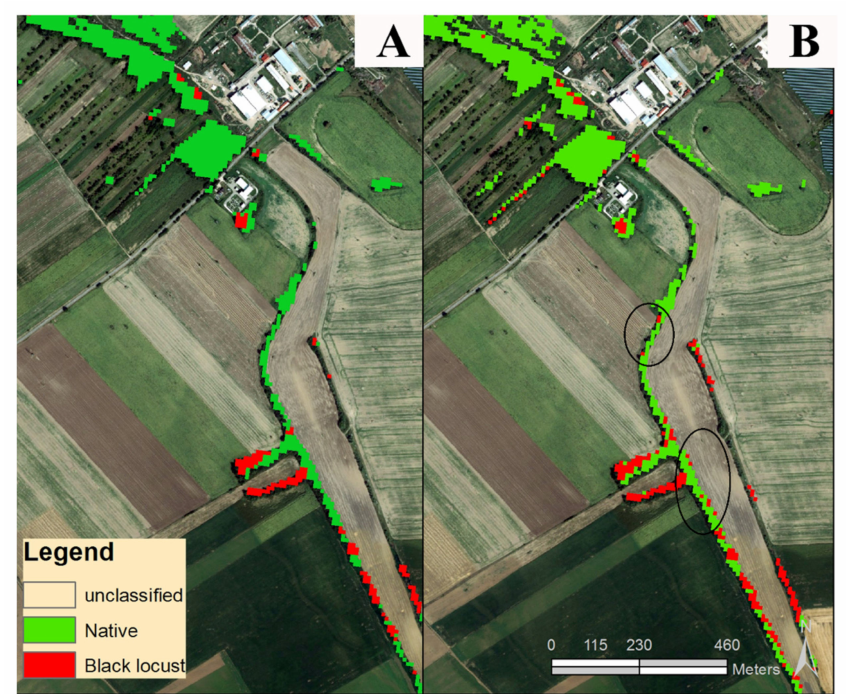
Figure 9. ( A ) Classification after majority filter; ( B ) classification before majority filter—black circles showing typical misclassifications of black locust at the edges of the small woody